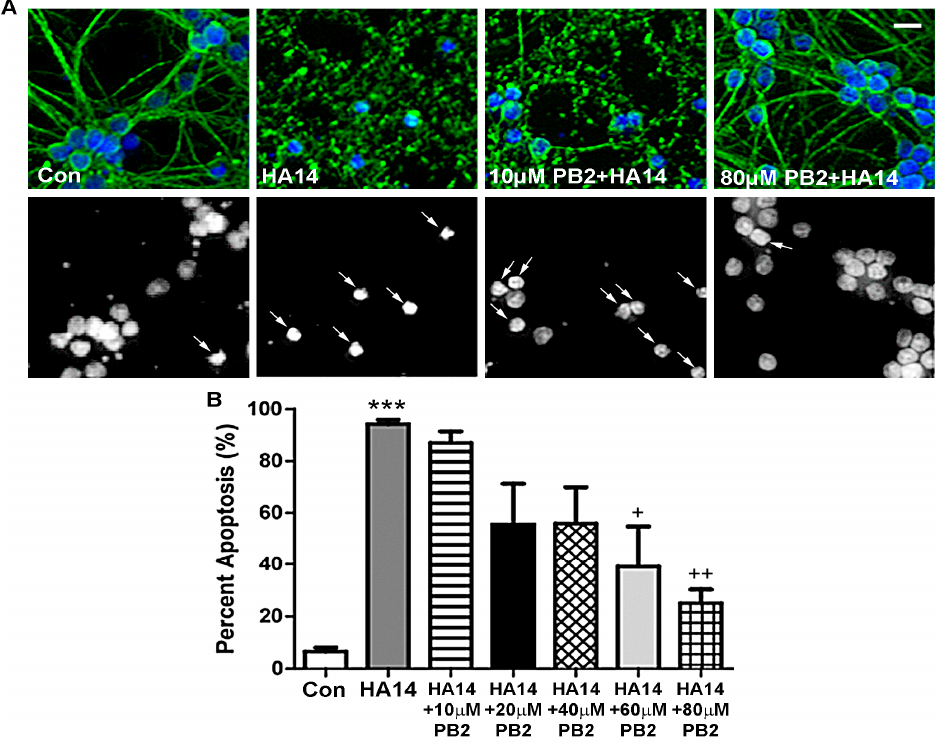
Figure 3. PB2 protects neurons from HA14-1-induced apoptosis in a dose-dependent manner. ( A ) CGNs were treated for 24 h with varying concentrations of PB2 and 15 µ M HA14-1, 15 µ M HA14-1 alone, and untreated control cells. Top panels show images of β -tubulin (green) and Hoechst stain (blue). Bottom panels show decolorized Hoechst fluorescence images of the same fields to better visualize nuclear morphology. Scale bar = 10 µ m. Arrows point to cells which were scored as apoptotic. ( B ) Quantitative analysis of percentage apoptosis of CGNs in untreated controls and cells treated with both 15 µ M HA14-1 and 0 µ M to 80 µ M PB2 for 24 h. Total cells and apoptotic cells were quantified and used to calculate percent apoptosis. Condensed or fragmented nuclei were considered to be apoptotic. Data are expressed as the mean ± SEM, n = 3. Data were analyzed by one-way ANOVA with a post hoc Tukey’s test. *** indicates p < 0.001 compared to untreated control. ++ indicates p < 0.01 and + indicates p < 0.05 compared to cells treated with only HA14-1.